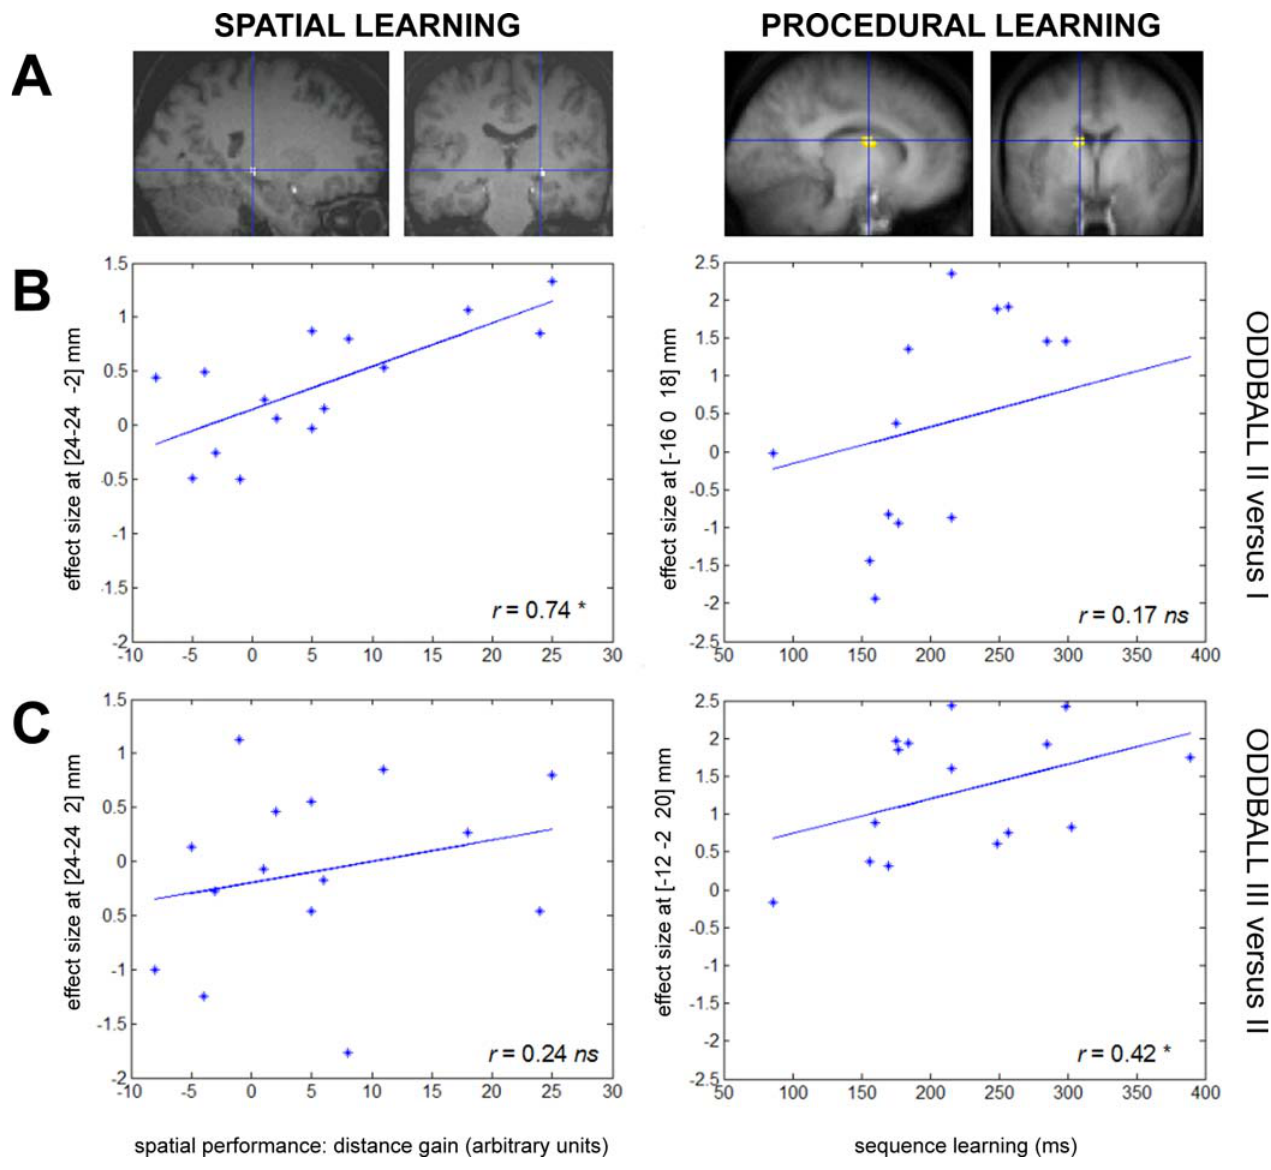
Figure 5. Post-Training Modulation of Neuronal Activity and Behavioral Performance (A) Activations are superimposed on one participant’s T1-weighted normalized MRI image. Left side: Plots of the correlation between changes in spatial performance (distance left to target in learning minus test sessions) and brain response during intervening oddball Session II (versus I; [B]) in the hippocampus ([24 (cid:1) 24 (cid:1) 2 mm], Z ¼ 3.75, p svc(10mm) , 0.05) around an a priori location [26 (cid:1) 24 (cid:1) 8 mm]). Each point represents one participant. Part C shows the non-significant correlation ( p . 0.8) at the same location during Session III (versus II). Right side: Plots of the correlation between individual levels of sequence knowledge (RT for novel minus learned sequence) at the end of the Learning phase and brain response during (B) Session II (versus I), showing the non-significant correlation in the left caudate nucleus, and (C) intervening oddball Session III (versus II[C]) in the same location ([ (cid:1) 12 (cid:1) 2 20 mm], Z ¼ 4.48, p svc , 0.005). r ¼ correlation coefficient. DOI: